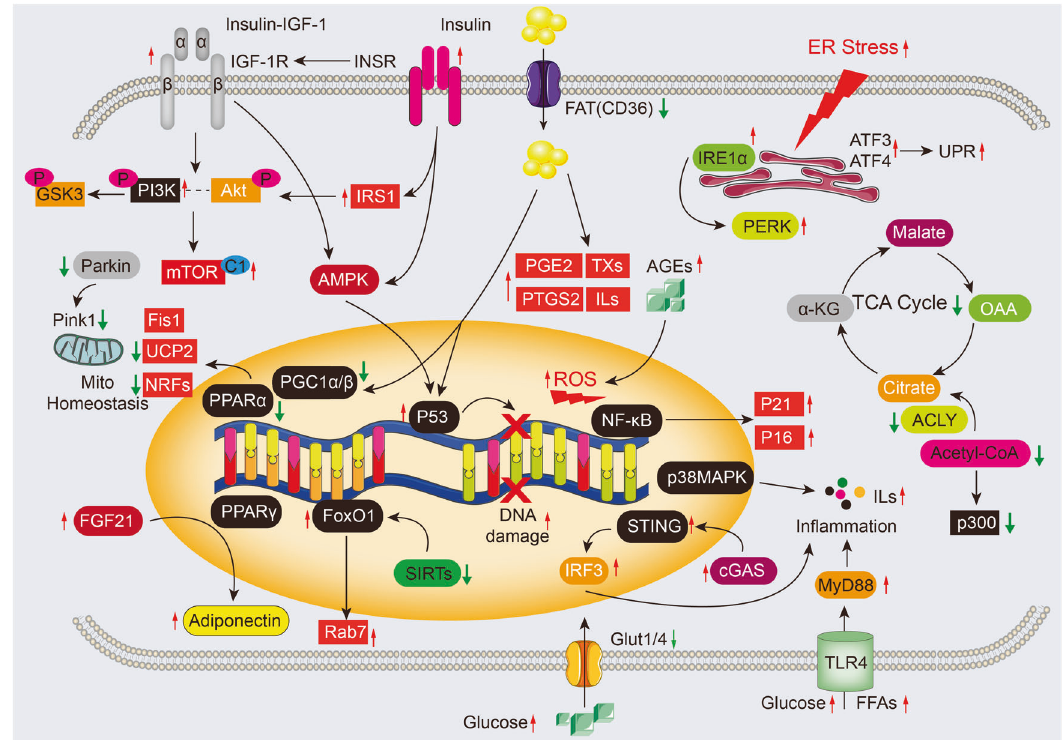
Fig. 5 Molecular mechanisms and potential signaling for cardiac aging. The insulin/IGF-1 signaling pathway can activate signal transduction through the PI3K/Akt pathway, which in turn phosphorylates multiple targets, regulating the activity of the mTOR complex (mTORC1). IGF-1 also contributes to protein synthesis by activating the PI3K/Akt/mTOR and PI3K/Akt/GSK3 β pathways, which can lead to endoplasmic reticulum (ER) stress or protein degradation via the ubiquitin-proteasome system (UPS). In the presence of ER stress, activated IRE1 α and PERK can initiate proin fl ammatory and proapoptotic signaling pathways. Increased NAD + might contribute to SASP and aging by disturbing AMPK and p53 activation, as well as enhancing p38MAPK and NF-kB activity in senescent cells. During cardiac aging, the maintenance